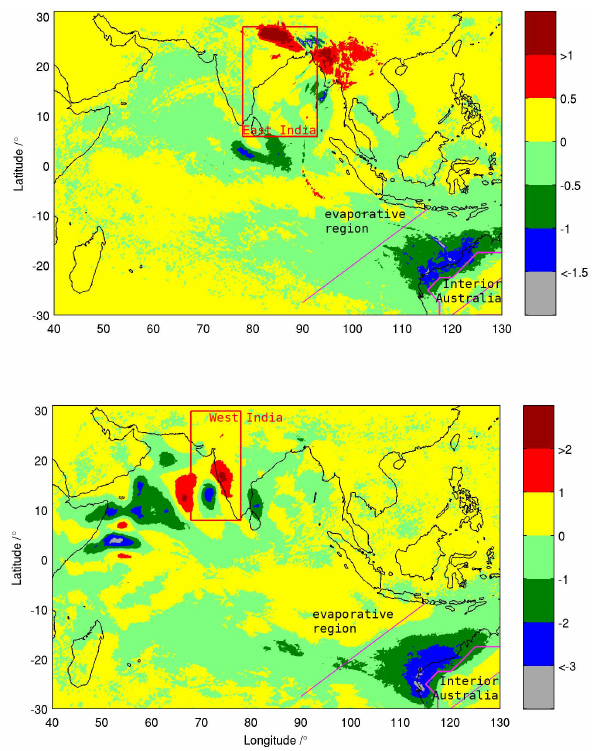
Fig. 1. (a) Climatological accumulated net water vapour sink p − e (cm/season) calculated from back-trajectories between India and Australia that precipitate first in the East India domain, for years 1972–2008. (b) Same but for the West India domain. Note that the colour scale used for the East India domain is half that used for the West India